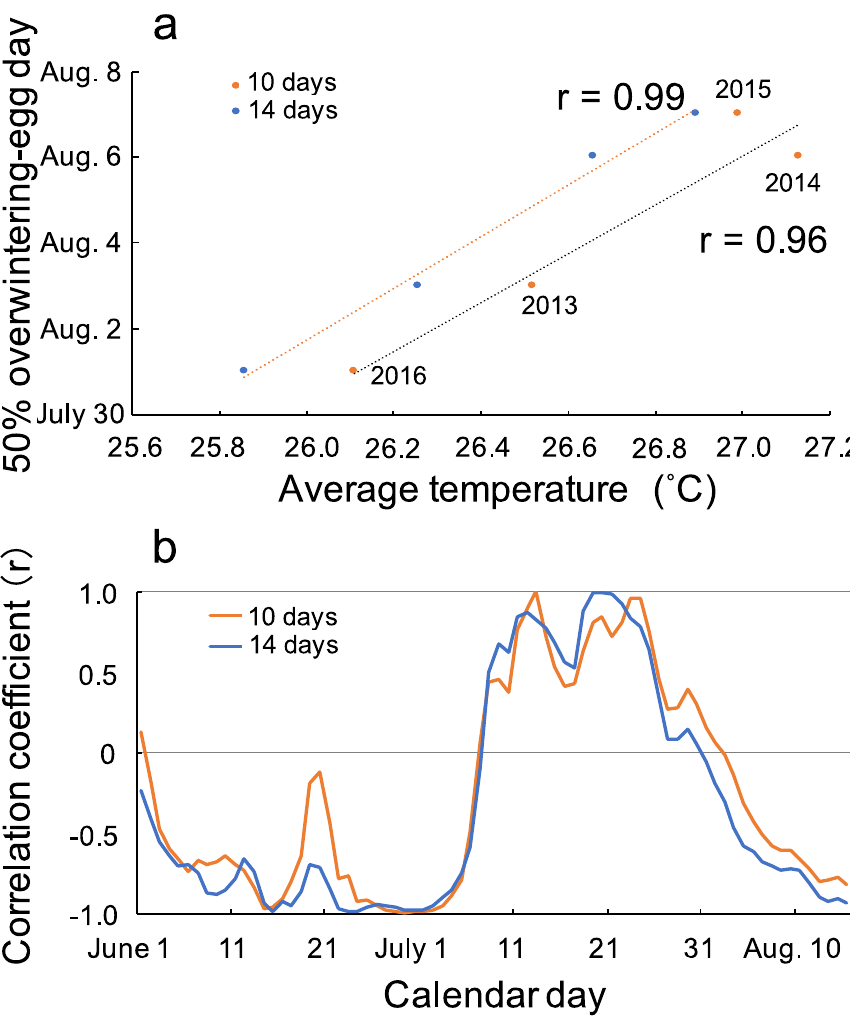
Figure 4. Relationship between temperature and the estimated day at which 50% of eggs laid on a given day would become overwintering individuals (the “switching” day). ( a ) Correlation between the mean temperature for 10 days from July 23 to August 1 or 14 days from July 19 to August 1 and the switching day. ( b ) Daily change in correlation coefficients between every 10 (14)-day mean temperature and the switching day each year. The curved line indicates that there was a high correlation between the mean temperature in mid- and late July and the switching day in